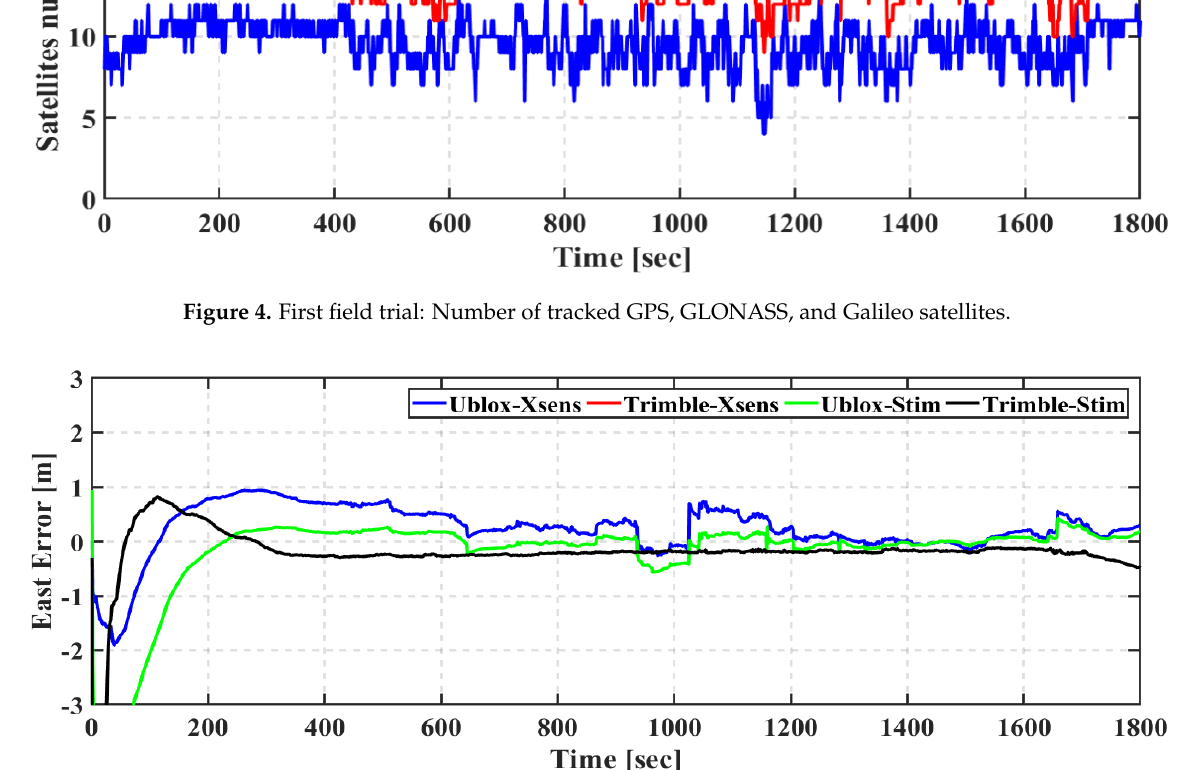
Figure 6. First field trial: North positioning error of real-time TC GNSS PPP/INS for Ublox–Xsens, Trimble–Xsens, Ublox– Stim, and Trimble–Stim solutions. Figure 7. First field trial: Up positioning error of real-time TC GNSS PPP/INS for Ublox–Xsens, Trimble–Xsens, Ublox– Stim, and Trimble–Stim solutions.